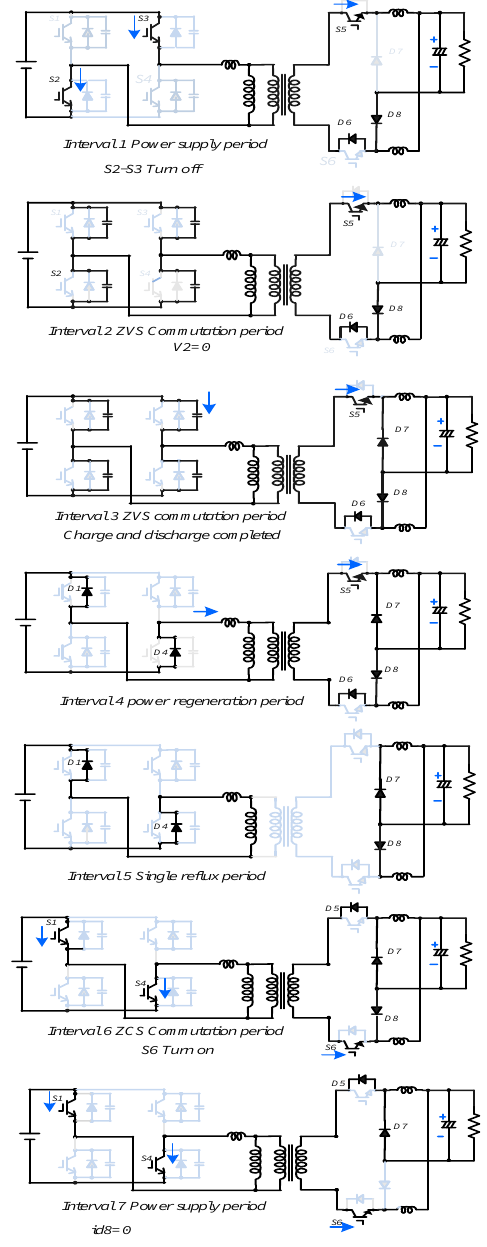
Figure 6. Operational intervals equivalent circuits.